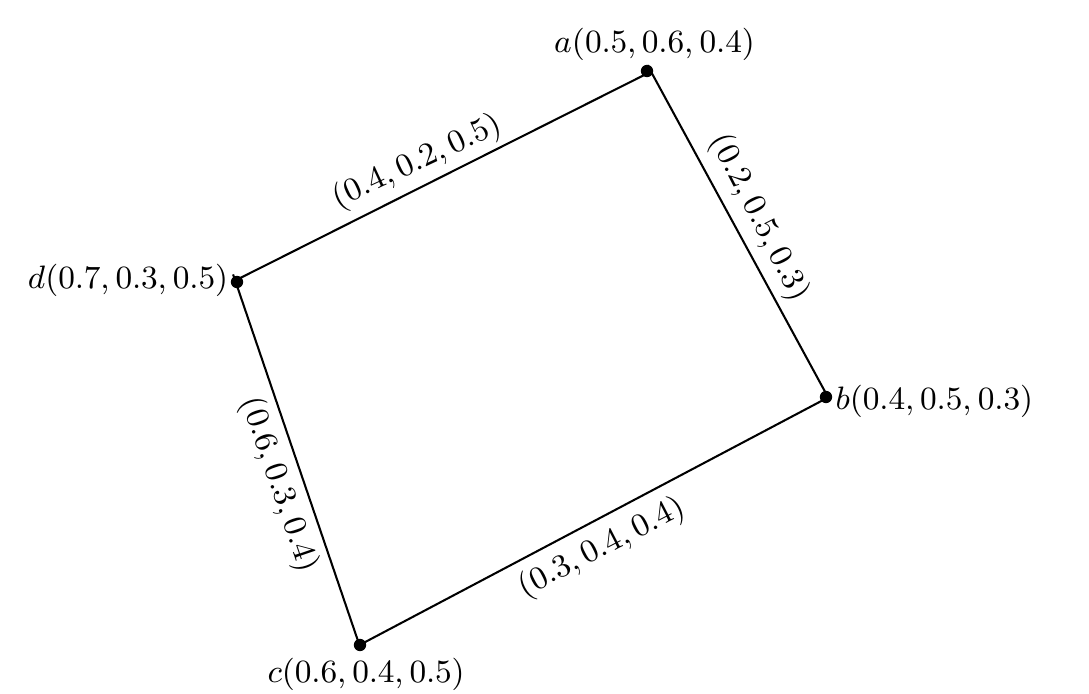
Figure 14. Strongly edge TI-SFG G Figure 14: strongly edge TI-SFG G